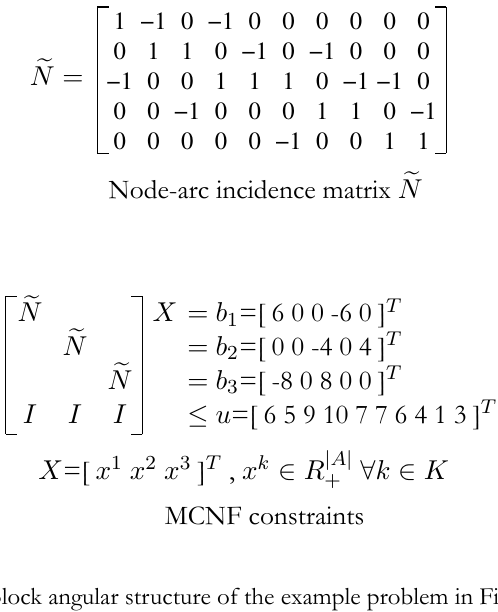
Figure 2: Block angular structure of the example problem in Figure